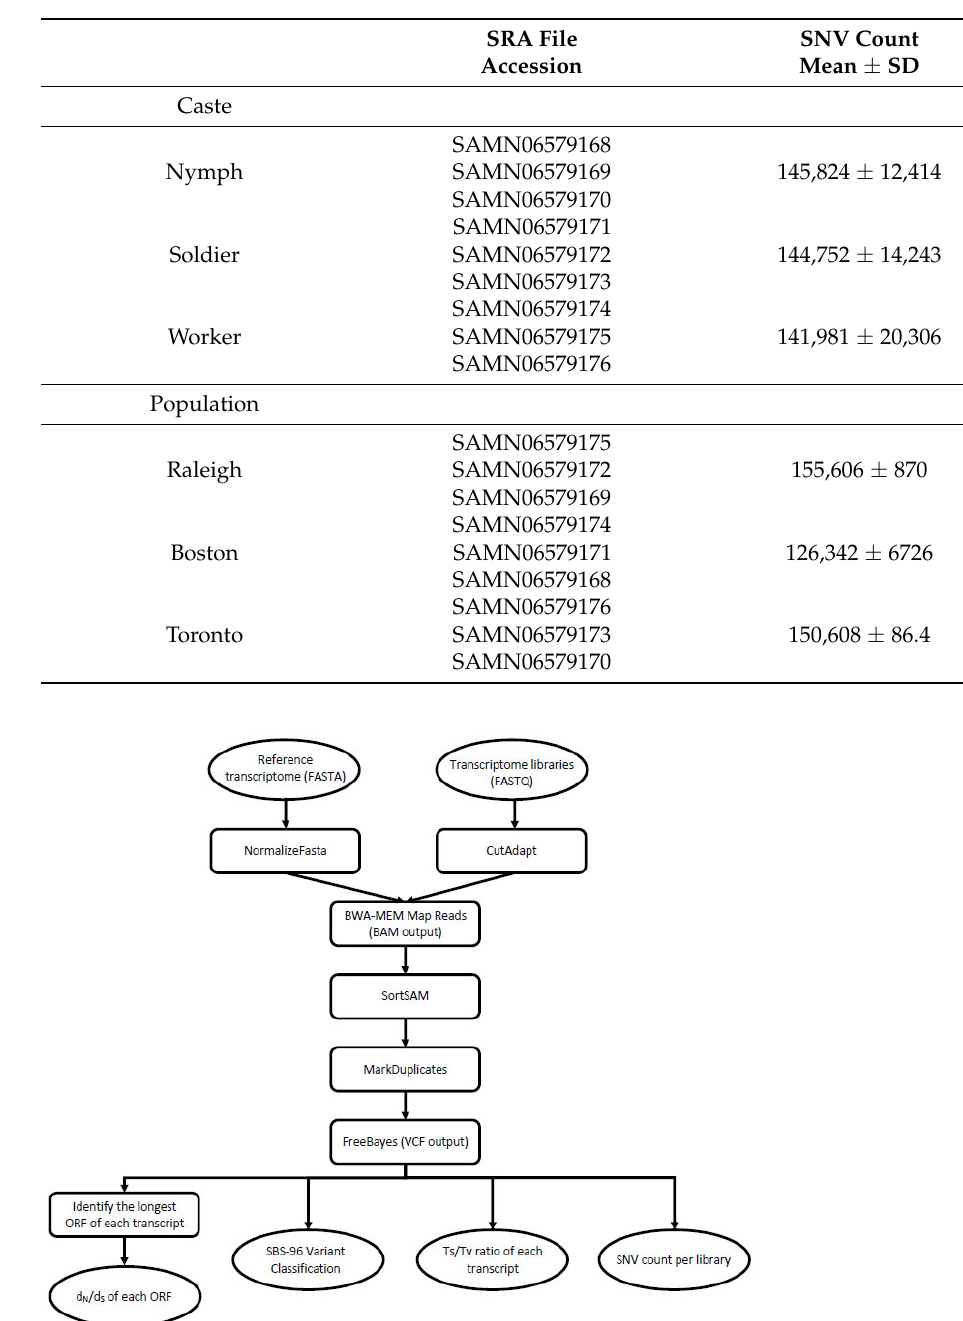
Table 1. Summary statistics for Reticulitermes flavipes SNV count by population and caste.